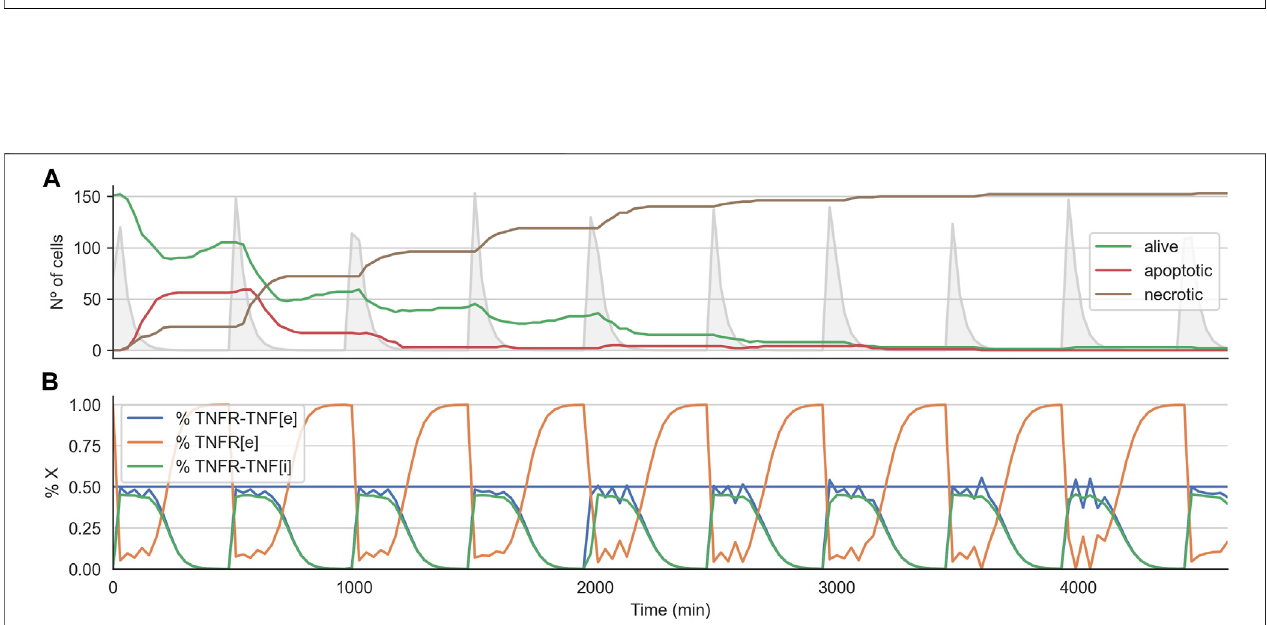
FIGURE 7 | Time course for effective treatment in the 2D cell arrangement with variability of 0.25. Panel (A) shows the time course for the number of alive, apoptotic, and necrotic cells. The light grey curve shows the TNF pulses. Panel (B) shows the average state of the TNFR receptor model across all the alive cells. The horizontal line indicates the threshold at which the signal induced by the binding of the TNF propagates downstream to the Boolean network.